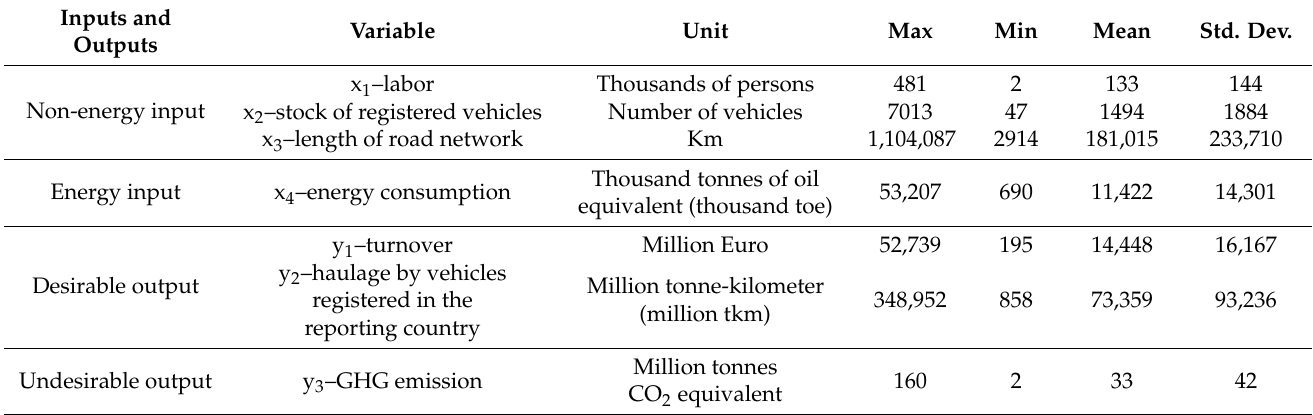
Table 3. Statistical description of selected output and input